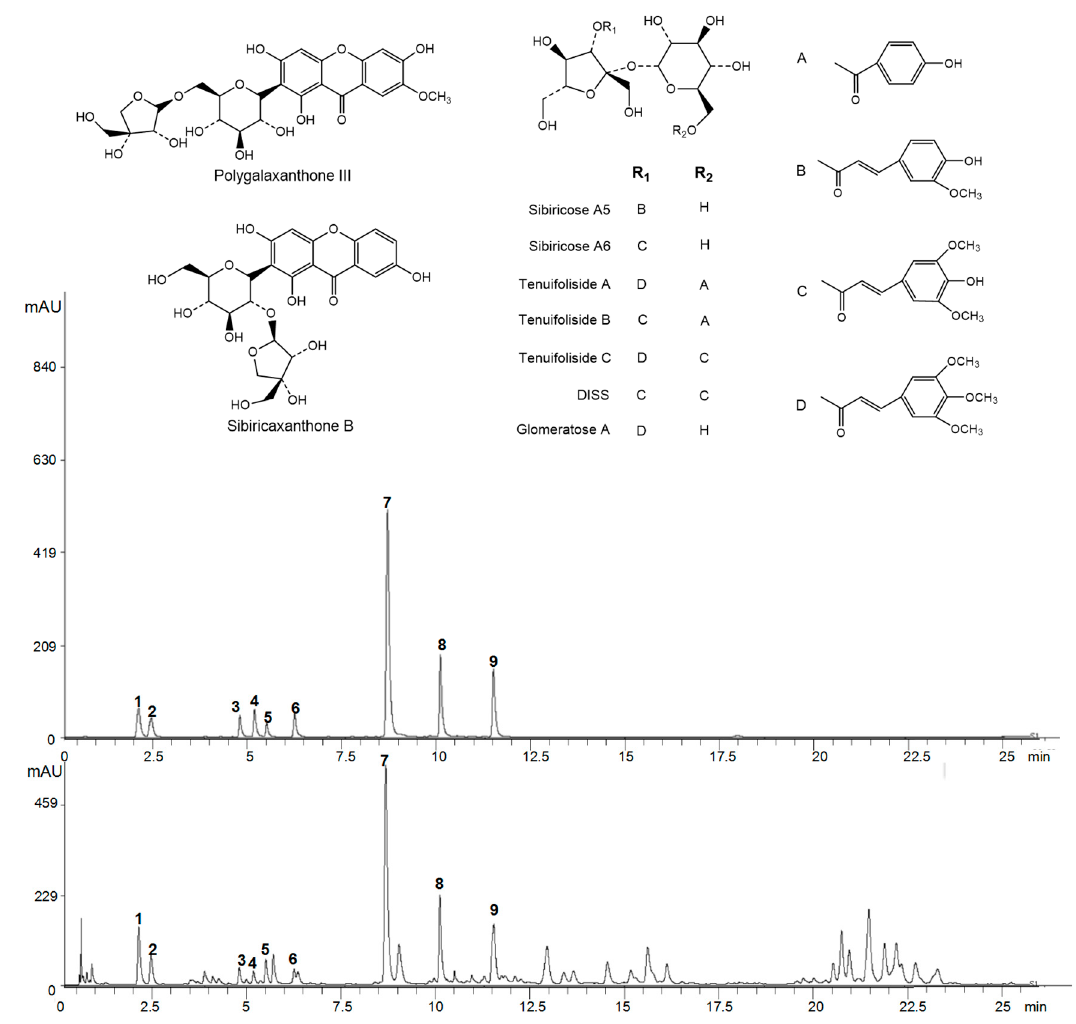
Figure 1. Chromatograms of a sample of P. tenuifolia and nine mixed reference standards. Note: 1: